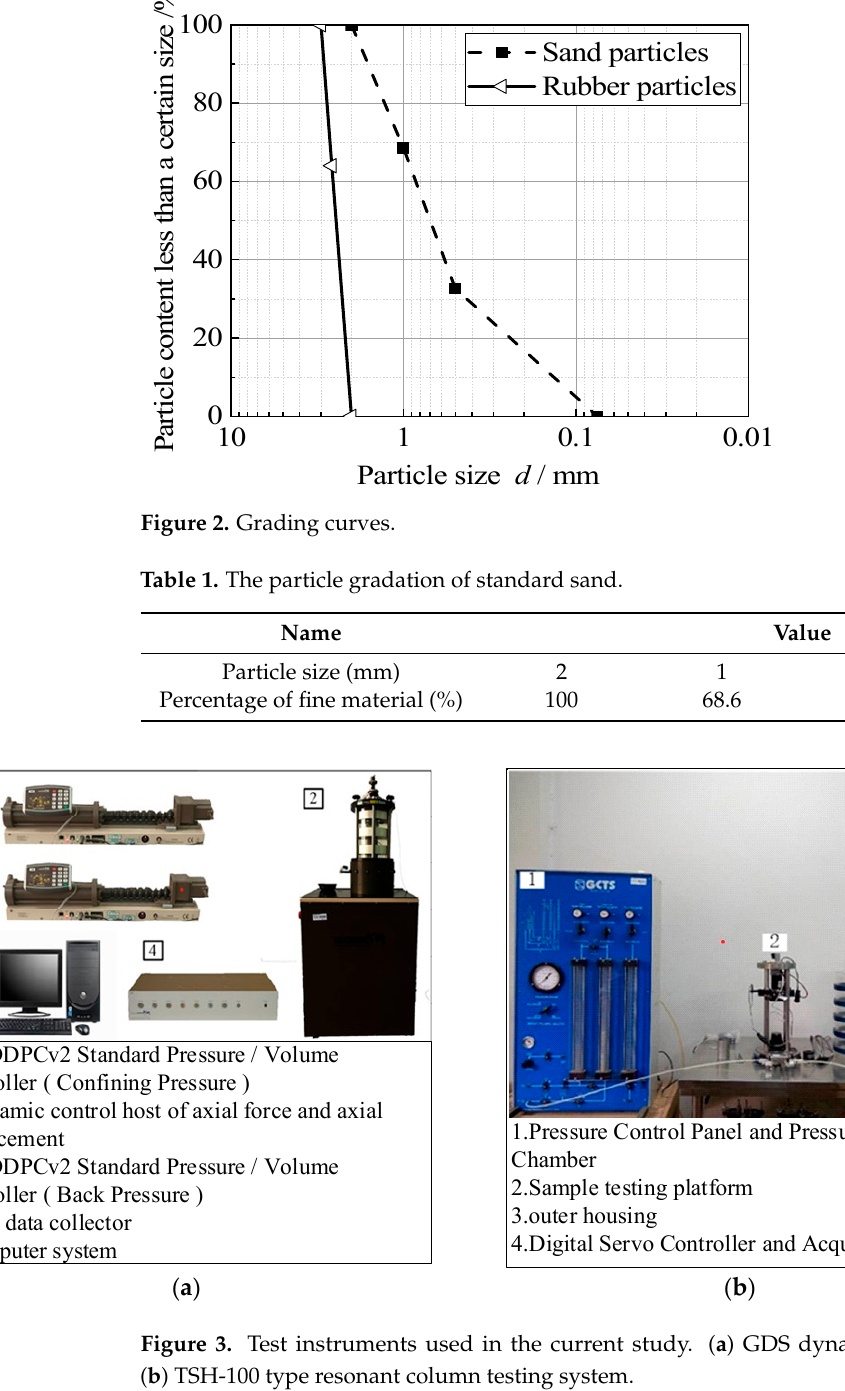
Figure 2. Grading curves. Table 1. The particle gradation of standard sand.